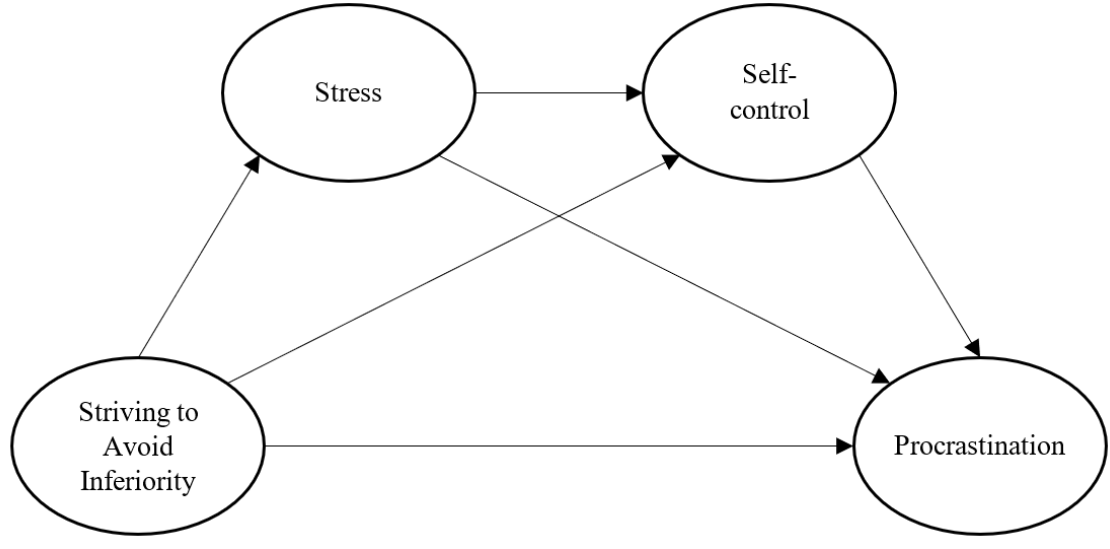
Figure 1. The hypothesized serial mediation model.